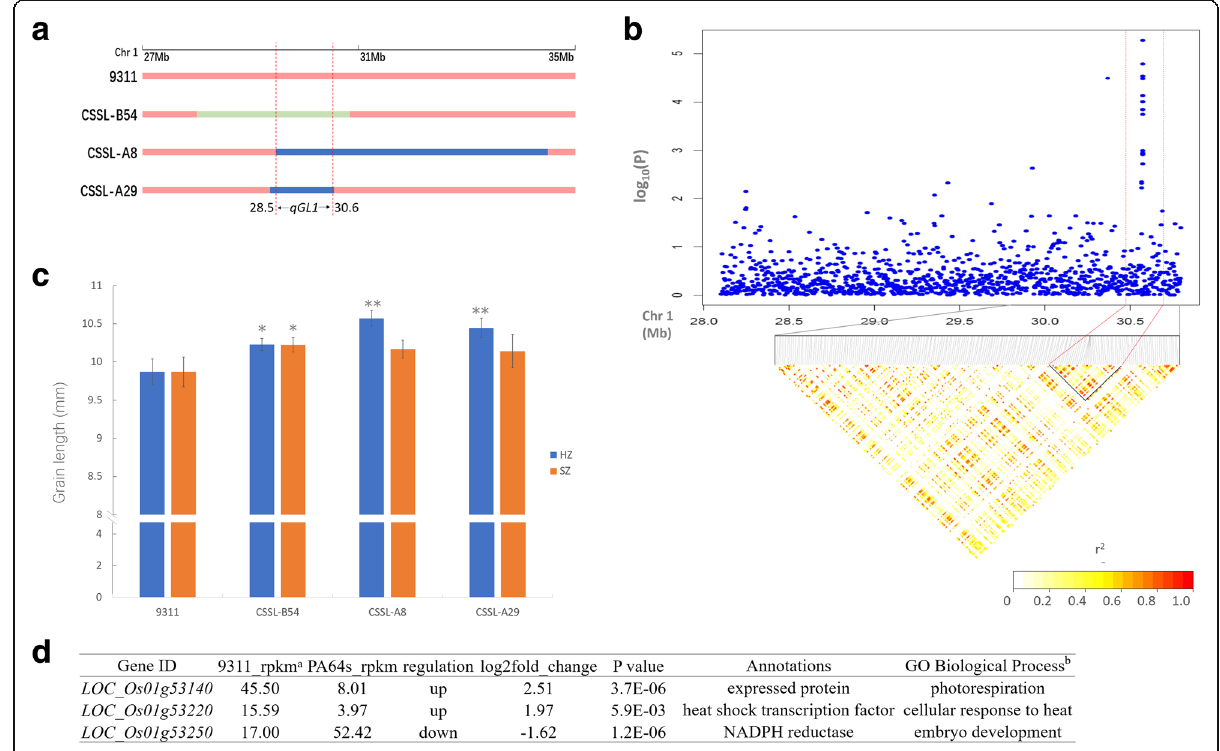
Fig. 5 Fine mapping of qGL1 . a the interval of qGL1 detected in A set CSSLs and B set CSSLs. Different colors represent different genotypes: red, 9311; blue, PA64s; green, Nipponbare. Dashed lines indicate the overlap regions in different CSSLs. b Local Manhattan plot (top) and LD heatmap (bottom) surrounding the peak on chromosome 1. Dashed lines indicate the candidate region for the peak. c variation of grain length between 9311 and 3 CSSLs. HZ and SZ represent Hangzhou and Shenzhen, respectively. Error bars are s.d. * and ** indicate the least significant difference at 0.05 and 0.01 probability level compared with the recurrent parent in SZ or HZ, respectively. d Differential gene expression and annotation. a rpkm is short for Reads Per Kilobase per Million mapped reads; b information refers to its Arabidopsis homologs at The Arabidopsis Information Resource